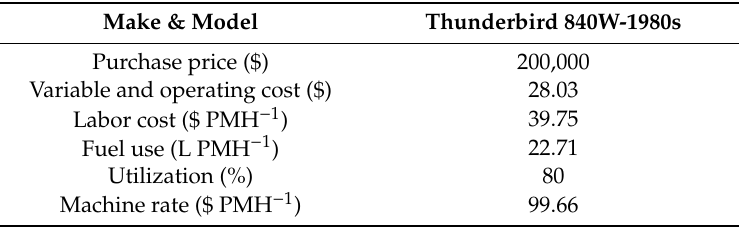
Table 2. Machine rates and other costs of the loader. The fuel cost was estimated to be $1.02 L − 1 . Machine rate per productive machine hours ($ PMH − 1 ) were calculated using the values of 2000 SMH (scheduled machine hours) year − 1 , 10% interest, and 3% insurance (provided by the company that operated and owned the